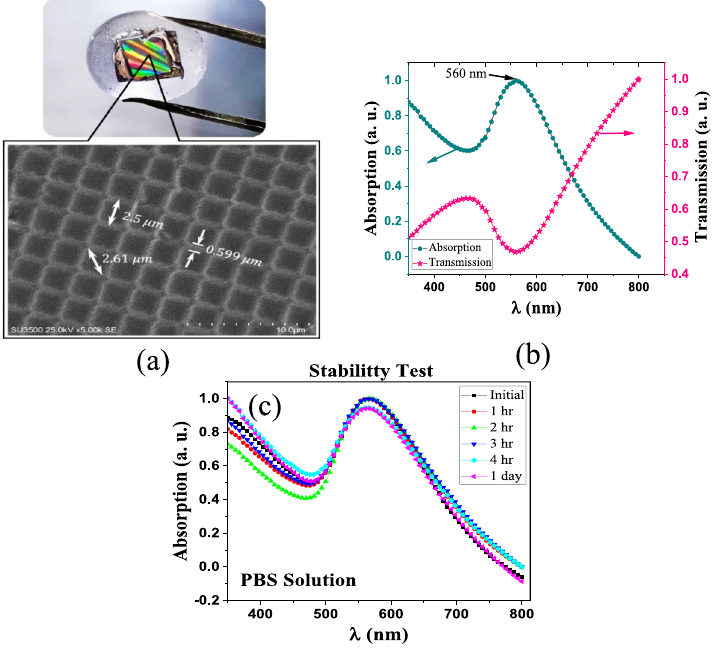
Figure 6. ( a ) The SEM image of the proposed 2D plasmonic PDMS-based contact lens, ( b ) measured absorption and transmission spectra of the fabricated 2D plasmonic contact lens, and ( c ) stability test of the fabricated 2D lens into the PBS solution for different times of 1, 2, 3, 4 h and 1